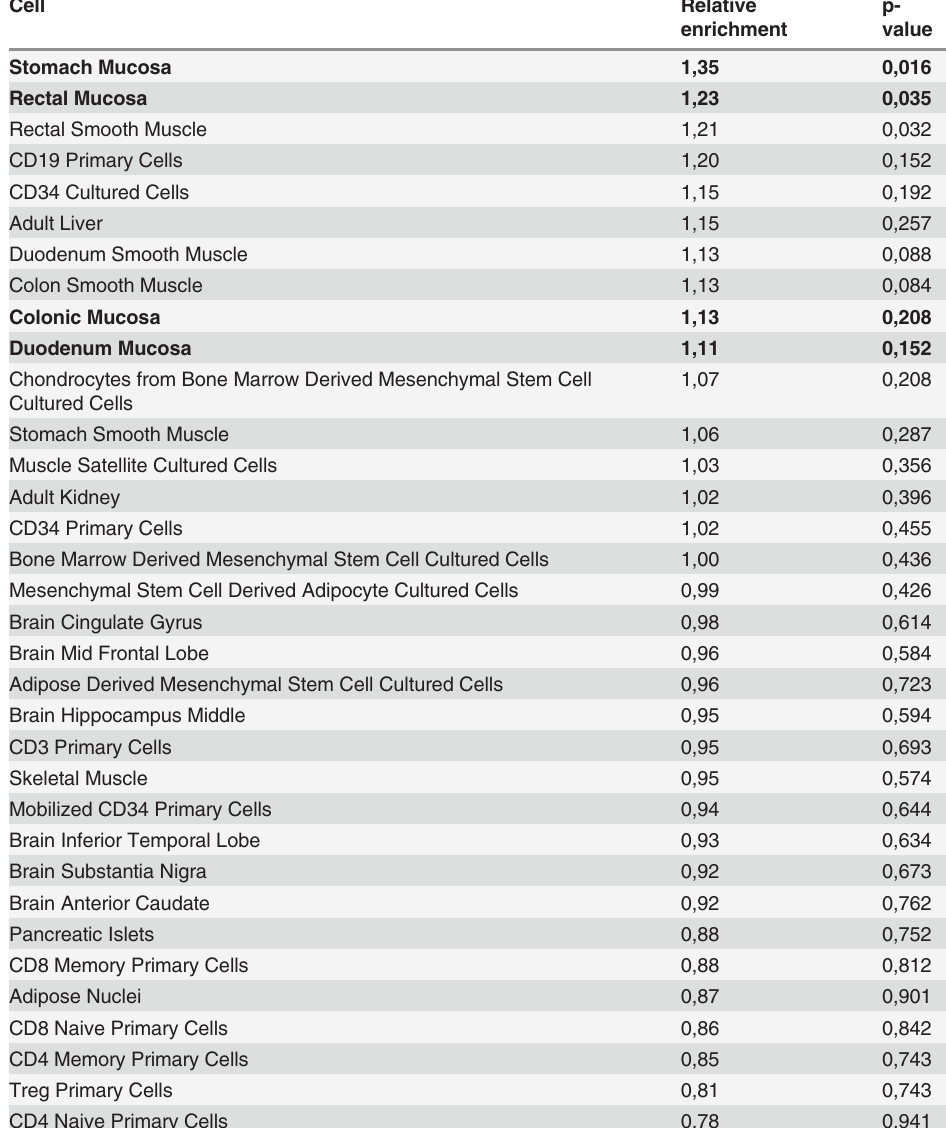
CD4 Naive Primary Cells 0,941 All four mucosal cell types in the dataset are among the top ten cells. Enrichment values are normalized so that a value of 1 corresponds to the average across all cell types (details provided in text). P-values are computed conservatively based on the relative enrichment, and are not adjusted for multiple